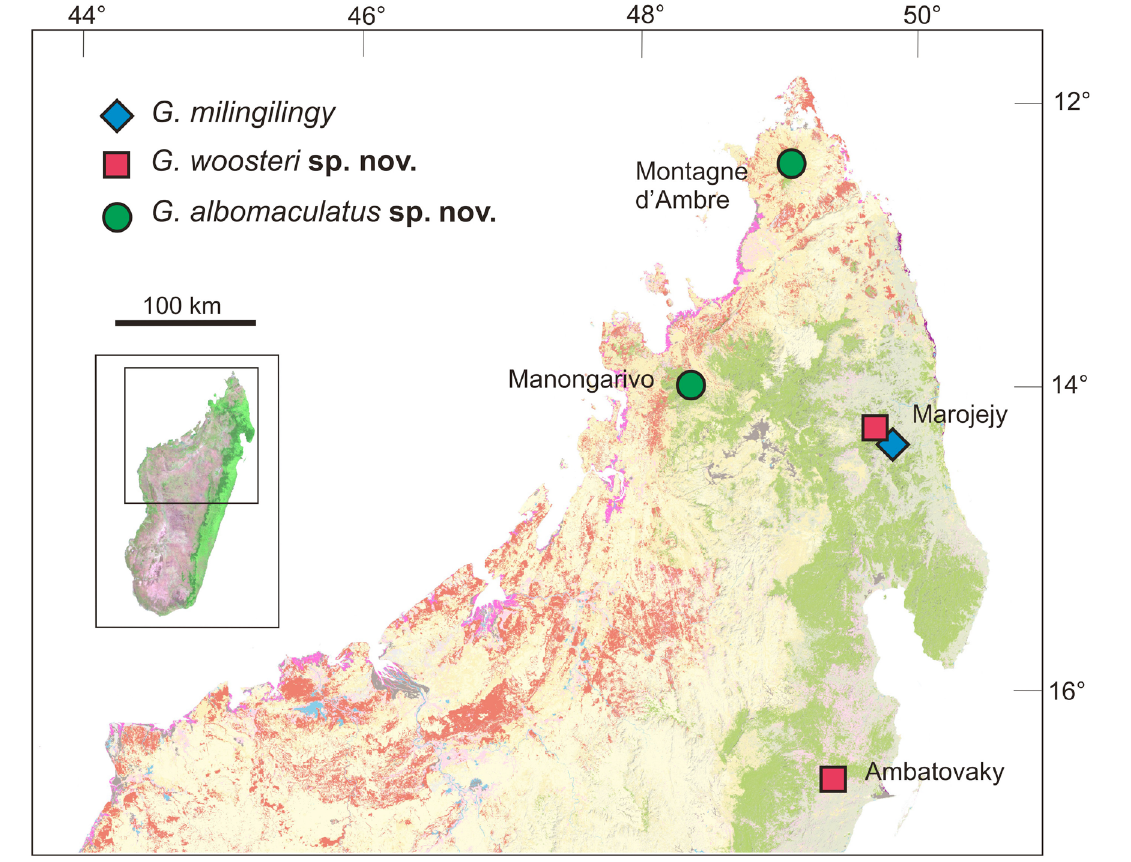
Fig. 2. Map of northern Madagascar, showing mostly verified distribution records of the two species of Guibemantis Dubois, 1992 described herein, and of the recently described G. milingilingy Bletz, Scherz, Rakotoarison, Lehtinen, Glaw & Vences, 2018. The locality Ambatovaky is only based on similarities in coloration and is in need of confirmation. The map shows the remaining primary vegetation of Madagascar (www.vegmad.org), green colors indicating rainforest, brown/orange colors deciduous dry